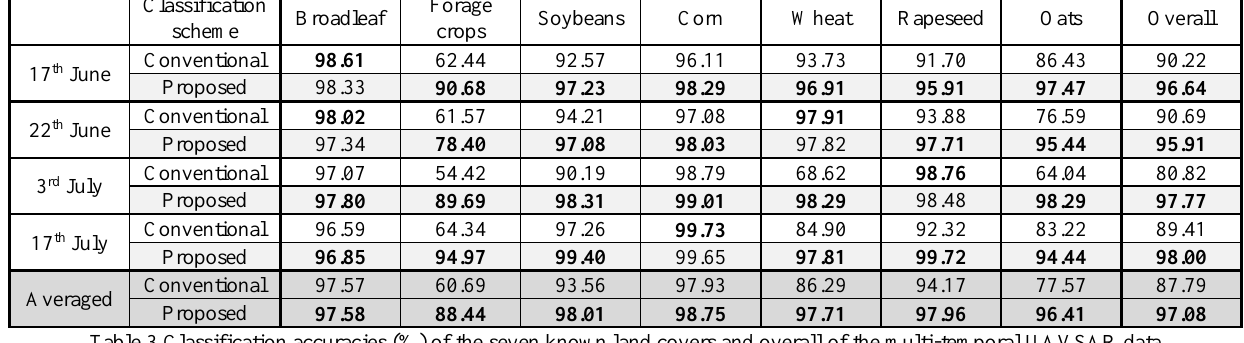
Table 3 Classification accuracies (%) of the seven known land covers and overall of the multi-temporal UAVSAR data